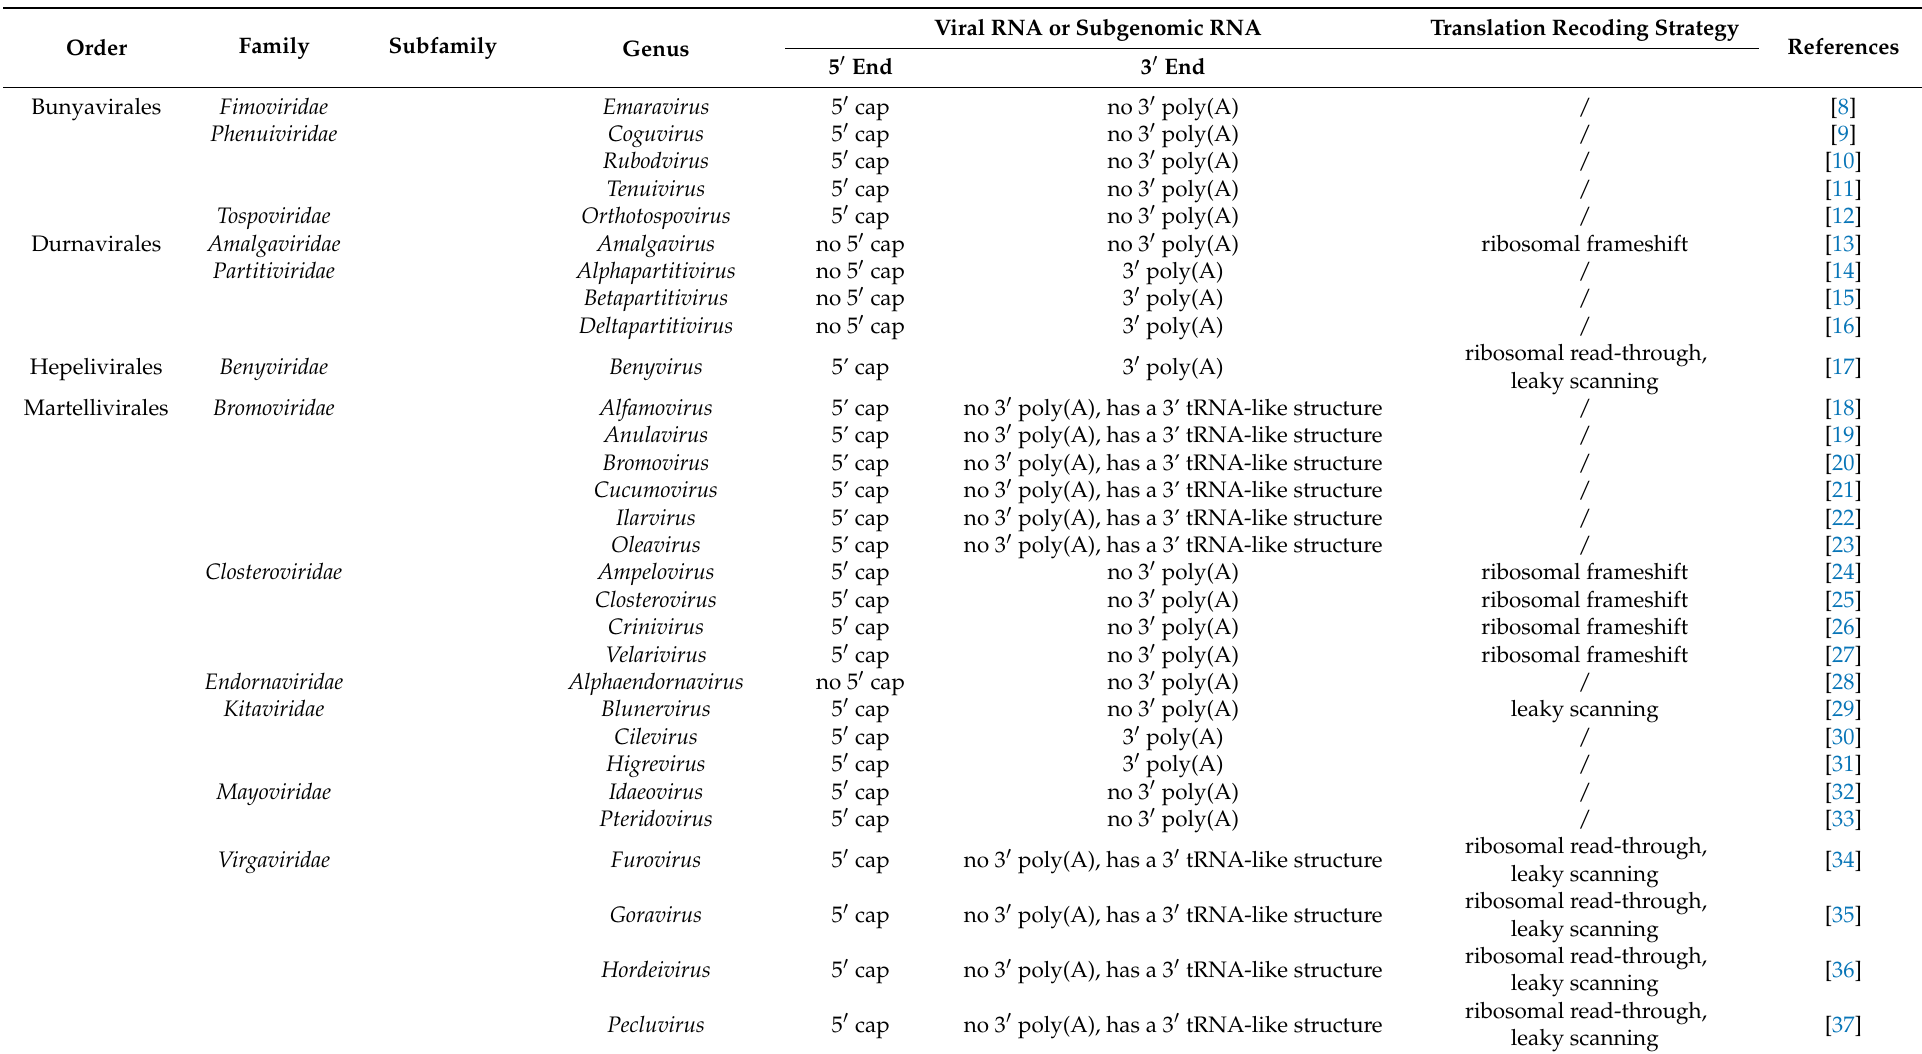
Table 1. Characteristic of 5 (cid:48) and 3 (cid:48) ends of plant RNA viruses and their potential translational recoding strategy.